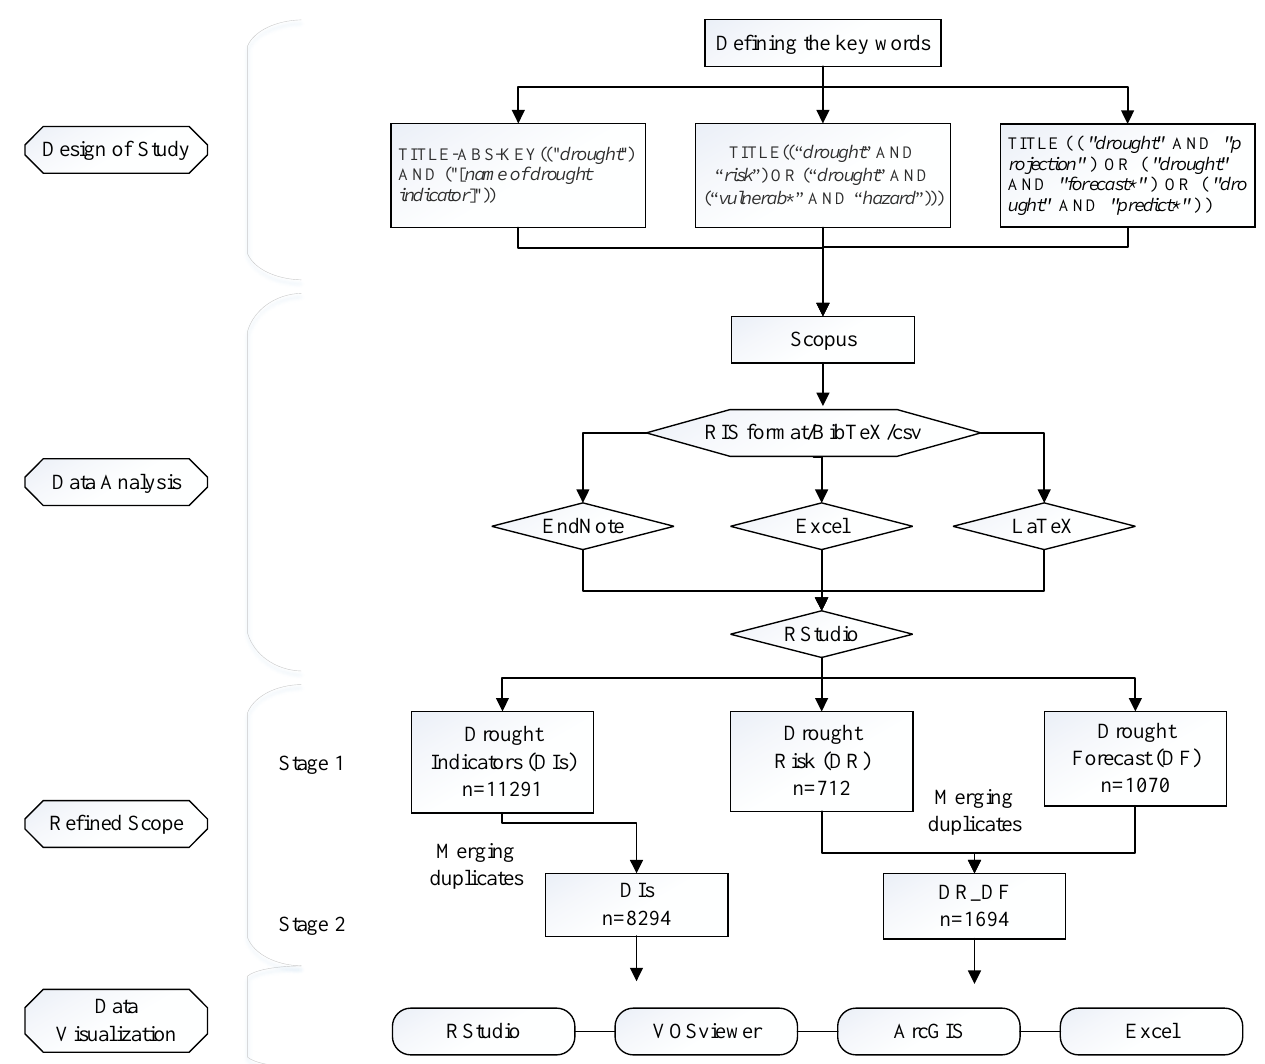
Figure 1. Workflow of adopted bibliometric analysis.